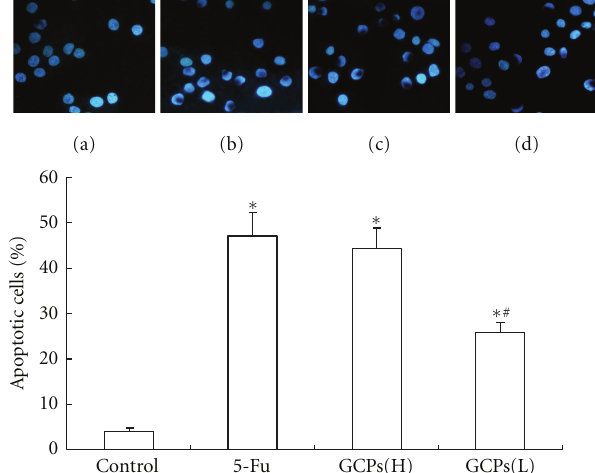
Figure 1: Hoechst-stained nuclei of apoptotic myocytes were analyzed morphologically and were expressed as the percentage of total nuclei (magnification × 400). (a) NS control group; (b) 1.3mg/mL 5-Fu; (c) GCPs (H): 1.6 mg/mL GCPs; (d) GCPs(L): 0.8mg/mL GCPs. The percentage rate of apoptotic cells was presented in bar graph. The data were expressed as the mean ± SEM. ∗ P < 0 . 05 versus control. # P < 0 . 05 versus 5-FU.